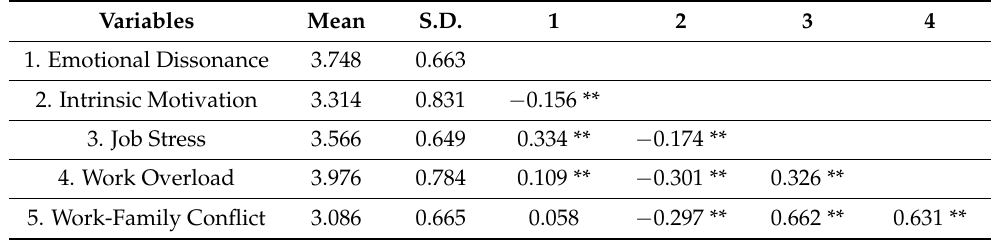
Table 2. Mean, standard deviation, and Pearson correlations.